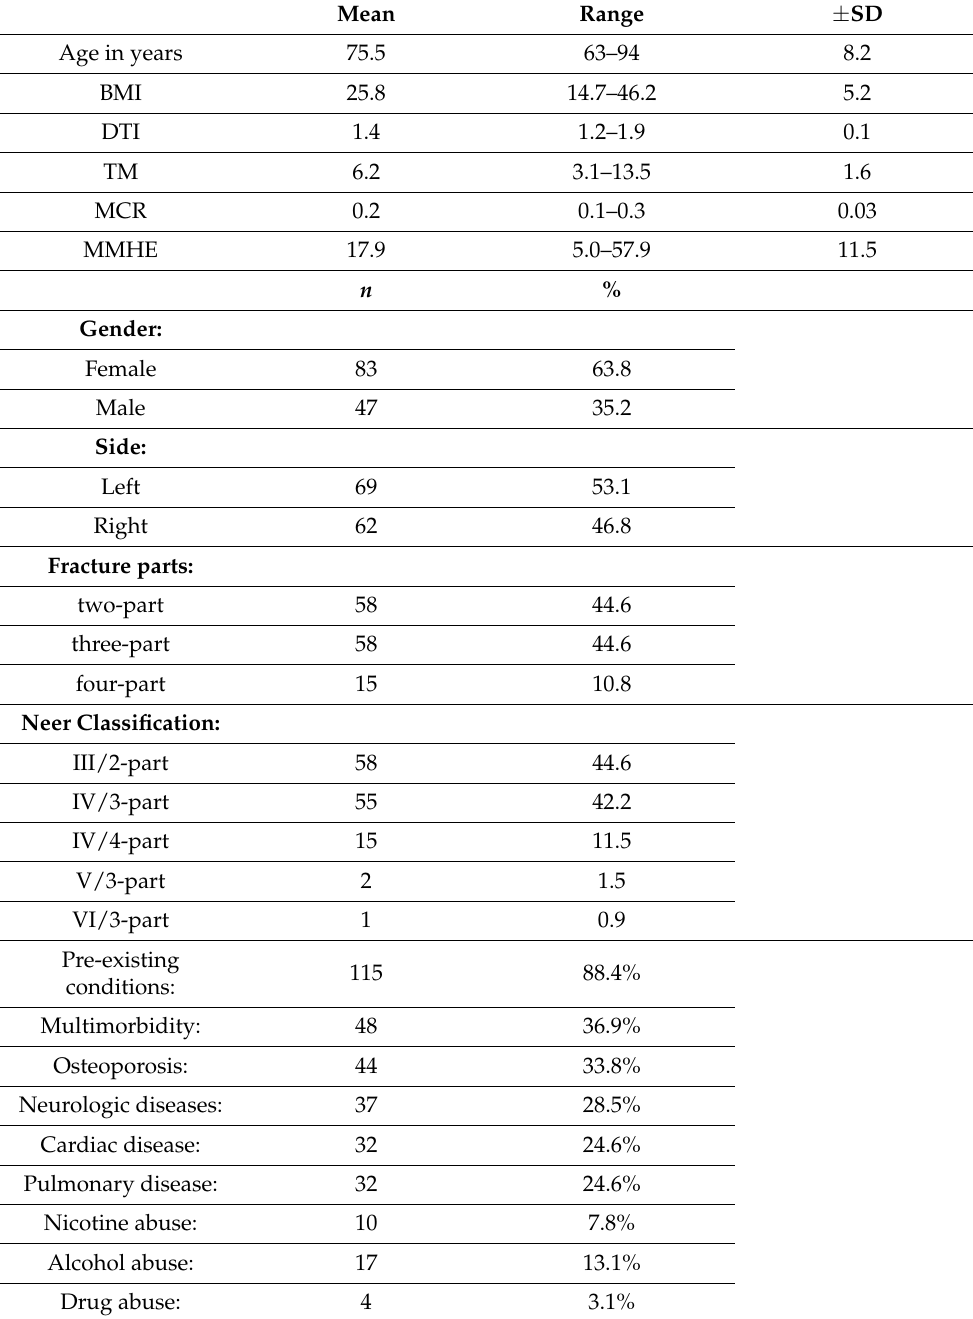
Table 1. Patient characteristics: BMI = body mass index, DTI = deltoid tuberosity index, TM = Tingart measurement, MCR = medial cortical ratio, MMHE = medial metaphyseal head